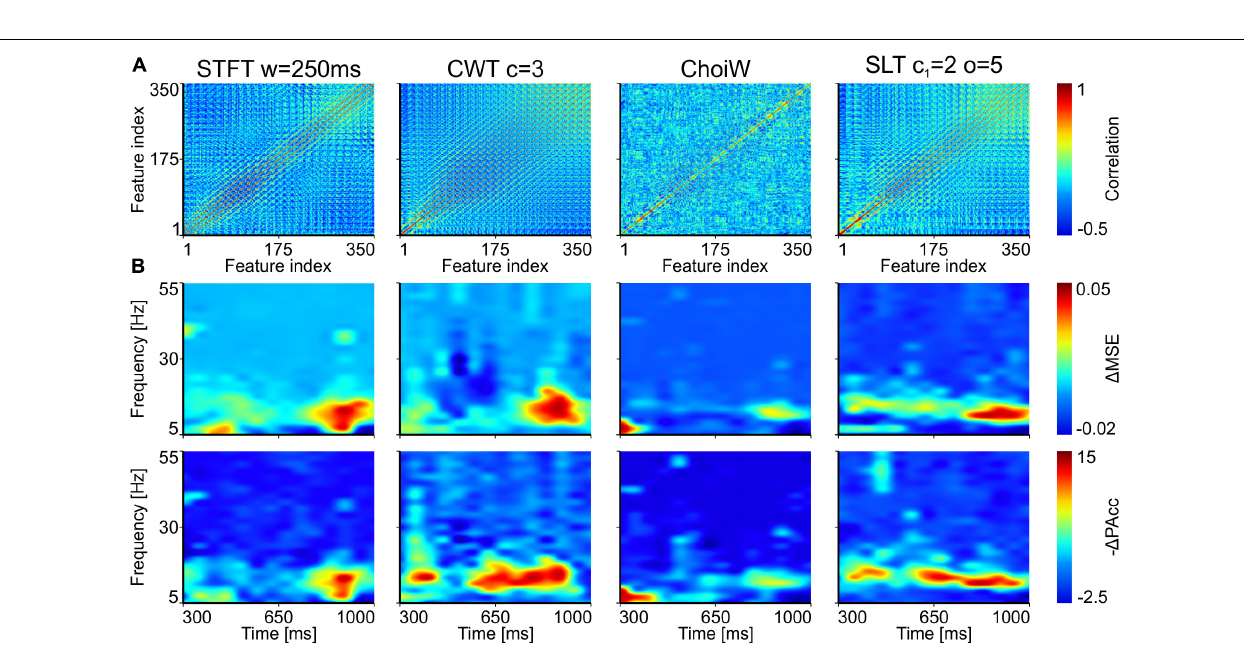
FIGURE 5 | Electroencephalography data with the Dots 30 stimulation protocol. (A) Table of TFRs where each row corresponds to the participant’s response (“nothing” or “seen”) and each column corresponds to one of the time-frequency analysis methods. First column on the left shows an example of the visual stimulus for a seen shape (a giraffe, top) and nothing (bottom). (B) Average accuracy as measured on the validation set (100 network initializations and dataset splits), with original and shuffled labels for chance level estimation. (C) Average learning curves on the validation set. Error bars are s.e.m.